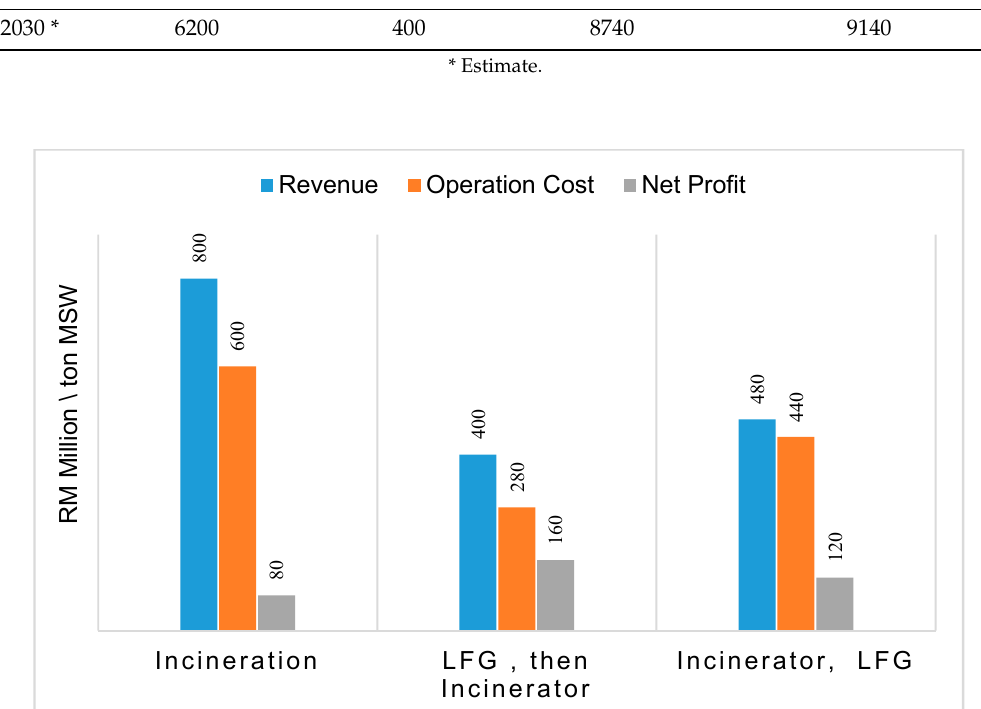
Figure 10. Summary of cost analysis of incineration operation [33].